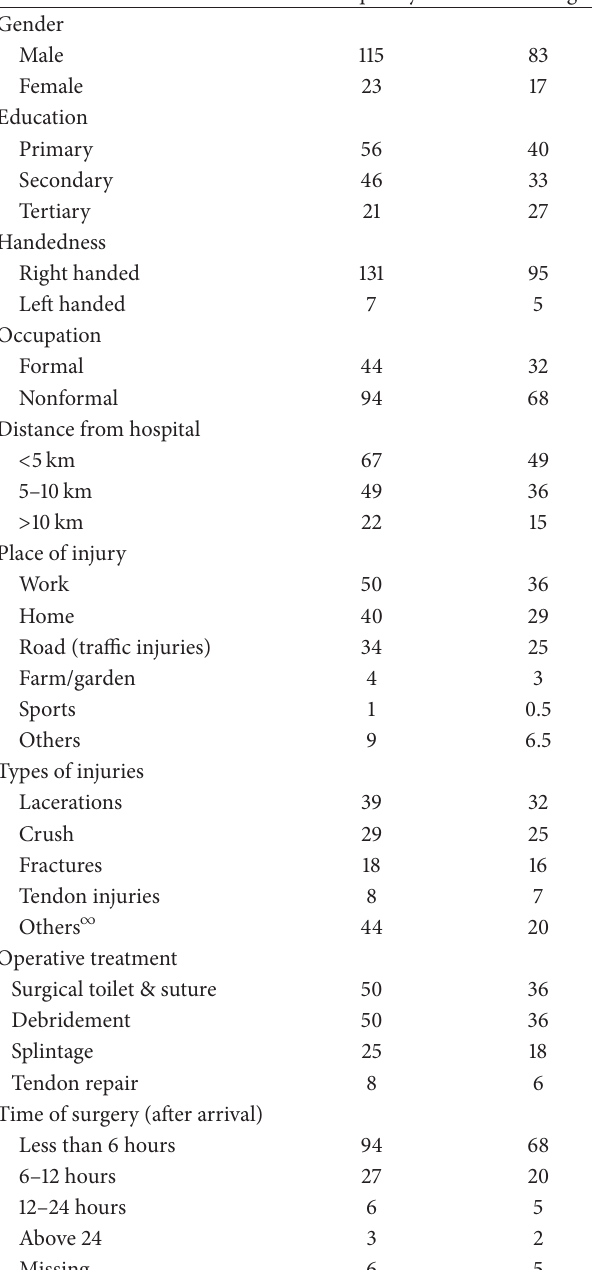
Table 1: Showing study participant characteristics. Table 2: The table shows postinjury outcomes after 4 weeks of follow-up.